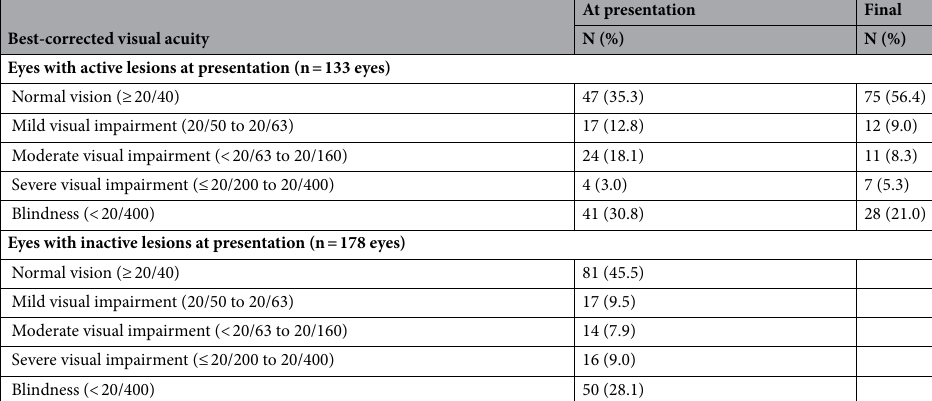
Table 3. Initial and final best-corrected visual acuity of eyes with ocular toxoplasmosis (n = 311 eyes*). *Best- corrected visual acuity could not be measured in 25 eyes (1 with an active lesion and 24 with inactive lesions) as subjects were preverbal children. For those with inactive lesions visual acuity at presentation = final visual acuity. Seven adults (8 eyes) were not followed until inactivation of ocular disease, and were removed from this